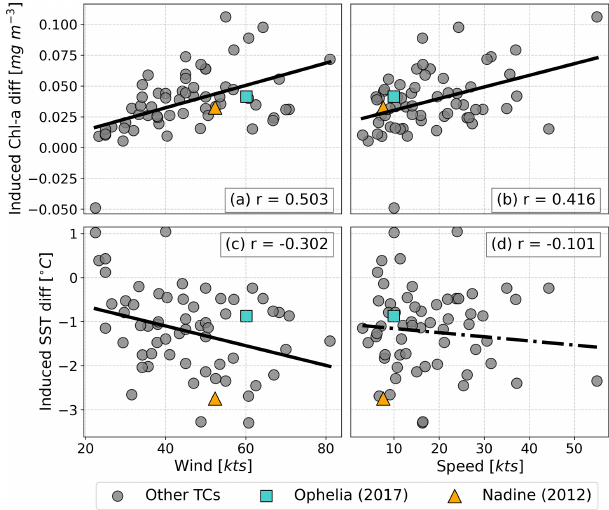
Figure 4. Linear regression of Chl a (a, b) and SST (c, d) in- duced anomalies for each TC, respectively, when compared with average winds in knots (a, c) and average TC translation speed in knots (b, d) . In each plot the Pearson R is presented, and the re- gression’s significance is marked by the type of line used in the re- gression, with a dashed line representing non-significant regression at a 95% confidence level and a solid line representing a regression significant at the 95% confidence